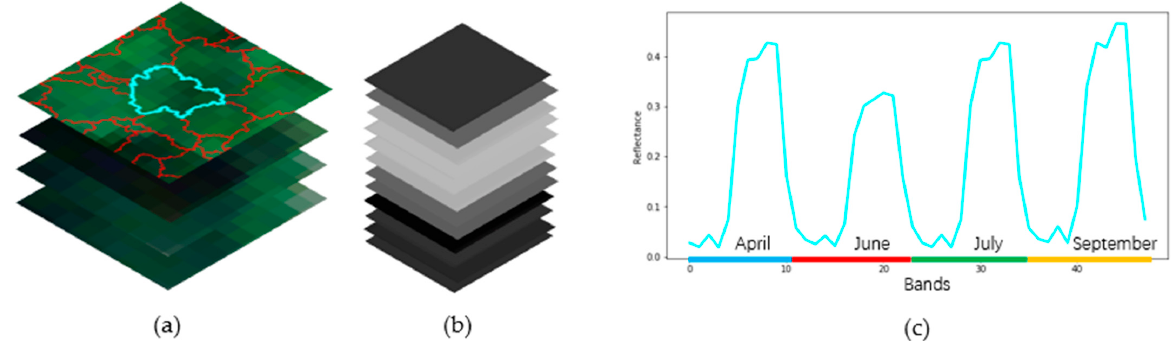
Figure 6. The reflectance curve of time-series image of a forest stand. ( a ) A forest stand. ( b ) The average reflectance of a forest stand for each band. ( c ) The reflectance curve across the stacked time-series bands.